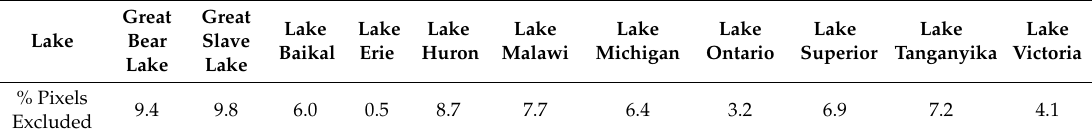
Table 2. Proportion of pixels excluded due to chlorophyll-a (CHL)